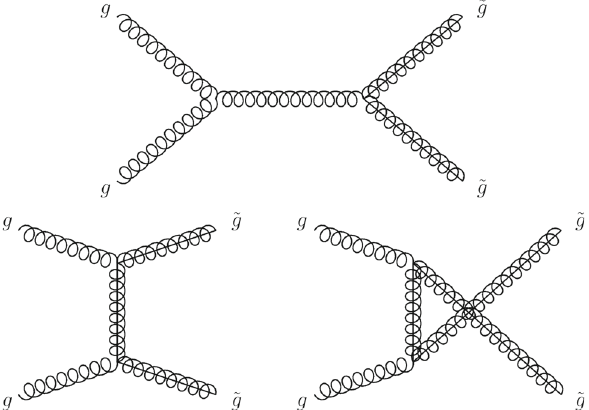
Fig. 65 Average flight distance in the laboratory frame of the gluino (cid:3) d flight (cid:4) as a function of the gluino mass m ˜ ˜ g fixed value of the neutralino mass m ˜ χ 0 black lines represent the geometrical limits of the tracker volume